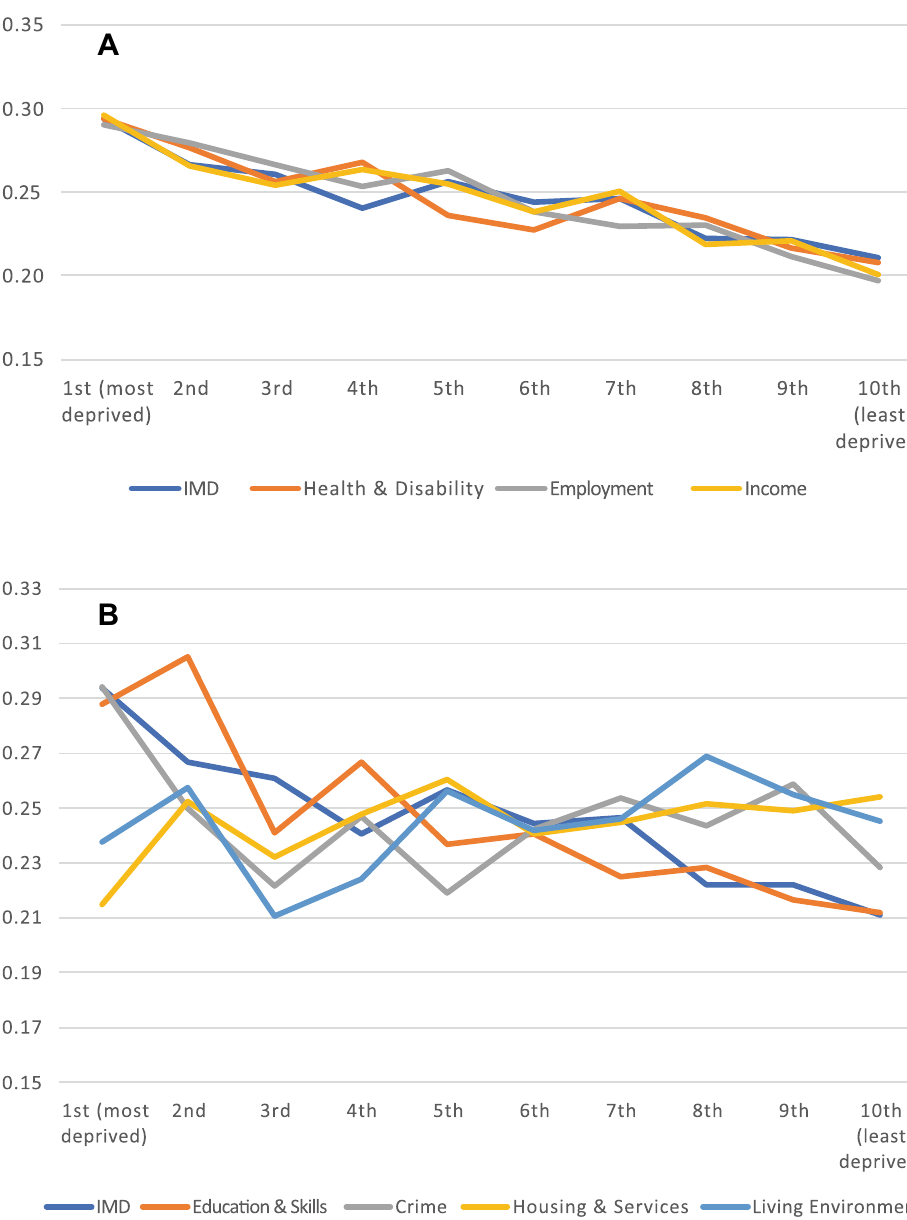
Figure 1. Multimorbidity rates by decile of neighbourhood deprivation domains. Panel ( A ) Health & disability, Employment, and Income domain. Panel ( B ) Education, Crime, Housing & Services, and Living Environment domain. Notes: Population estimates for England and Wales. Number of observations in each model: 24,520. For detailed results, see Supplementary Table S2 online. Source: Understanding Society (2020), Wave 10, linked with ONSPD (Nov 2020) and Index of Multiple Deprivation (2019) at the LSOA 2011